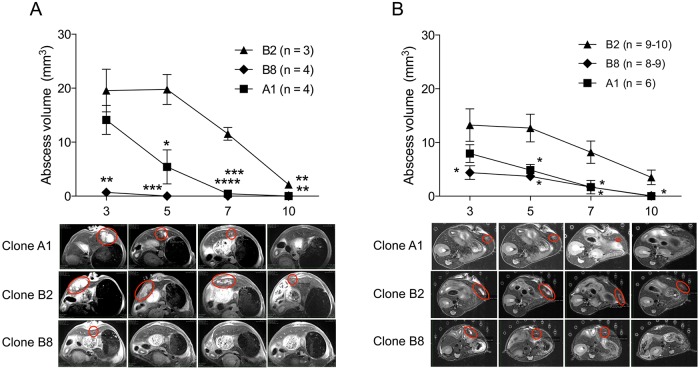
Analysis of the time course of ALA formation after infecting gerbils (A) and mice (B) with clones A1np, B2p or B8np.Gerbils were infected with 1 × 106 trophozoites, and mice were infected with 2.5 × 105 trophozoites. Abscess sizes were determined on days 3, 5, 7 and 10 post infection using magnetic resonance imaging (MRI). Abscesses are shown in red circles. Significance was established using an unpaired t test. p-values were calculated relative to control (clone B2p). *p < 0.05, **p < 0.005, ***p < 0.001, ****p < 0.0001. For detailed information see S1 Table.